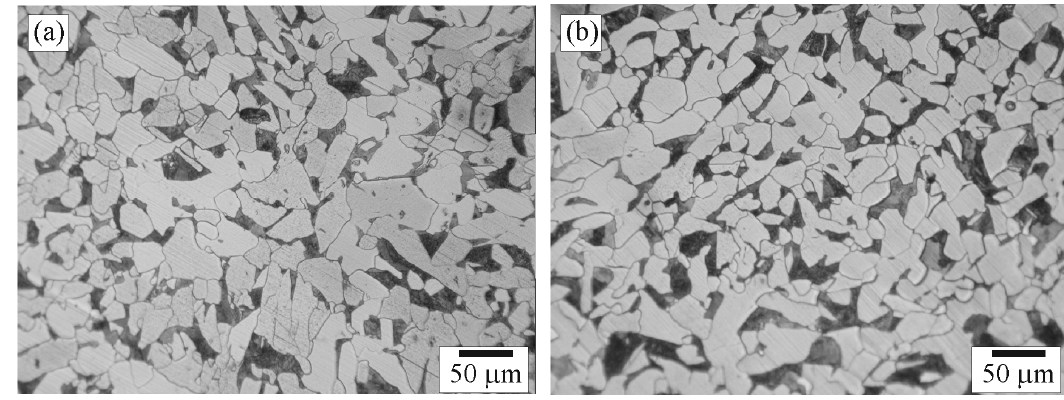
Figure 8. Optical micrographs of positions: ( a ) Ea; and ( b ) Eb in Zone E.